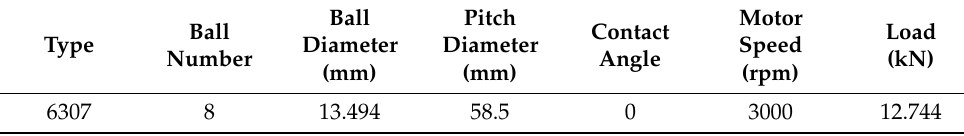
Figure 6. The test rig. Table 1. The parameters of the test rolling bearing.